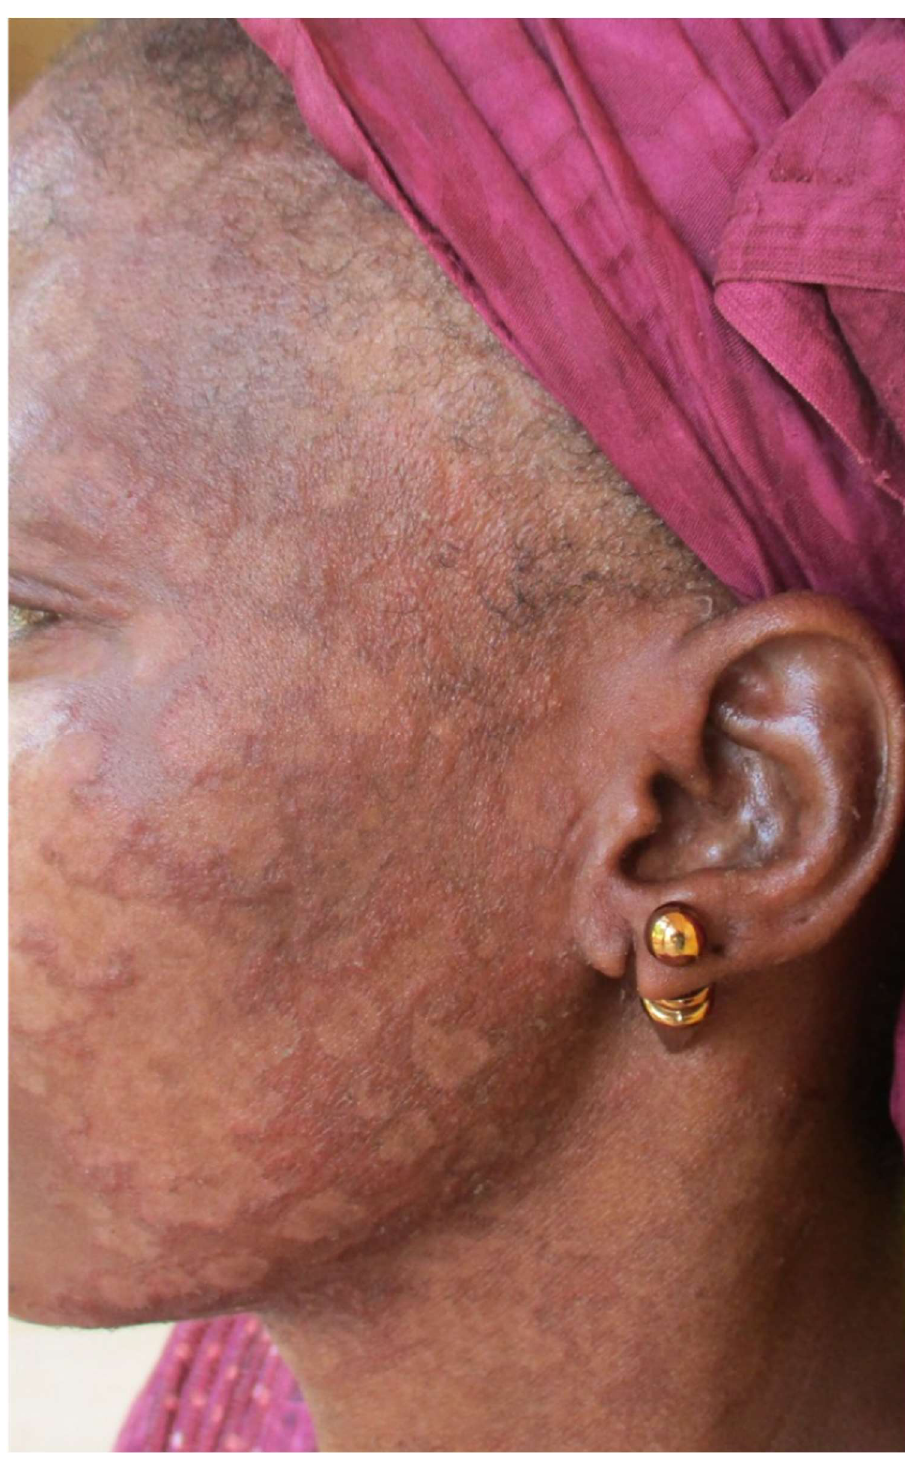
Figure 4. Tinea facei in women using skin bleaching creams (clobetasol and hydroquinone).